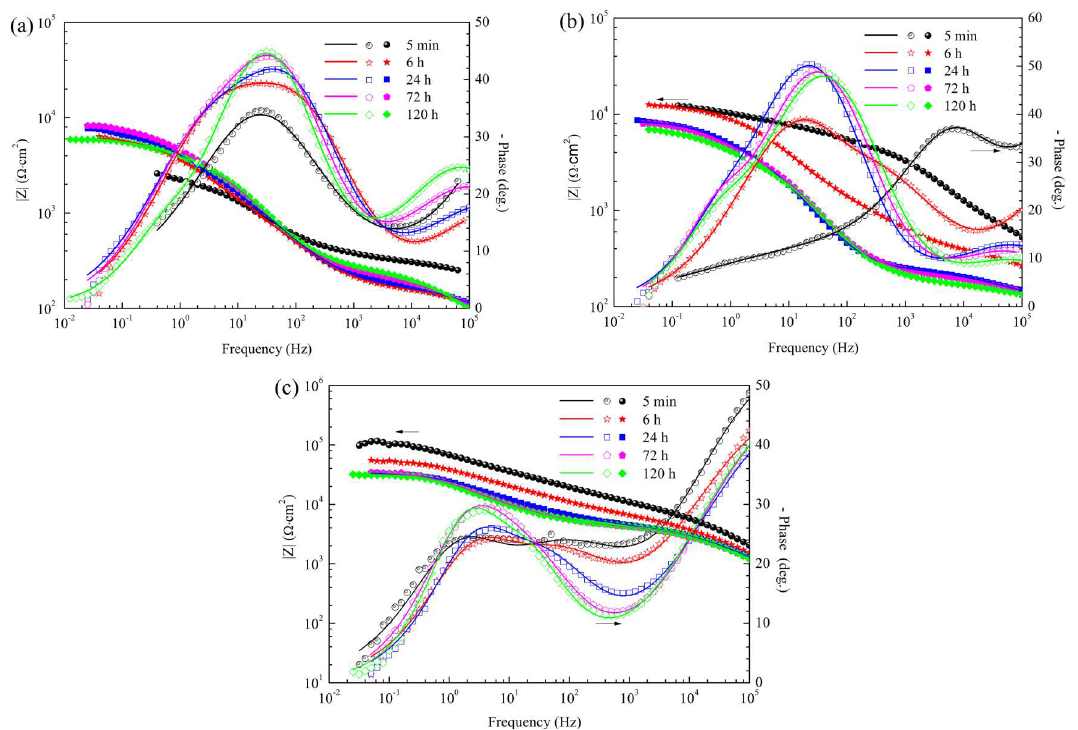
Figure 10. Bode plot of the CaPh-coated samples in SBF at 37 ± 0.5 ◦ C: ( a ) HT-C sample; ( b ) AT-C sample; ( c ) PEO-C sample. Symbols represent experimental data and solid lines are fitted data.